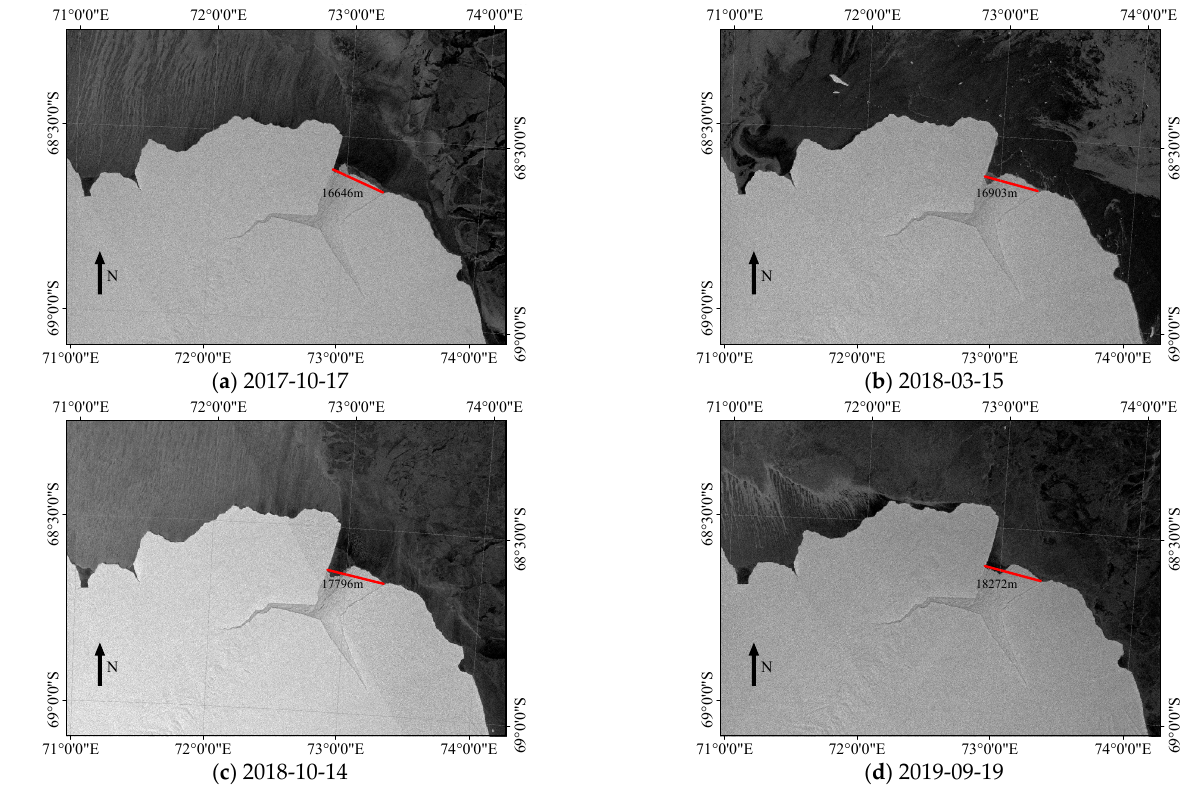
Figure 7. The advanced AIS fronts from March 2018. The rift in Region 2 became wider and wider. The length of the rift is marked in the respective panel.